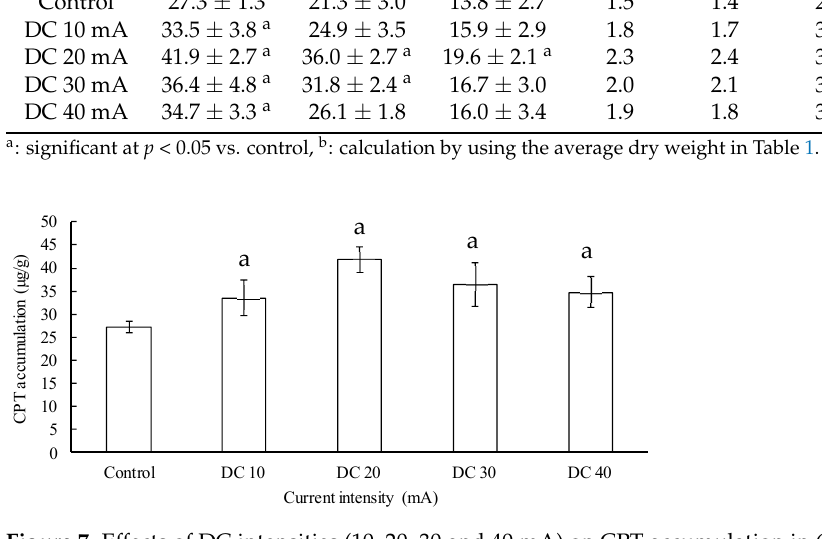
Figure 7. Effects of DC intensities (10, 20, 30 and 40 mA) on CPT accumulation in O. ridleyana roots. The values are expressed as mean ± SD ( n = 3); a: significant at p < 0.05 vs. control.